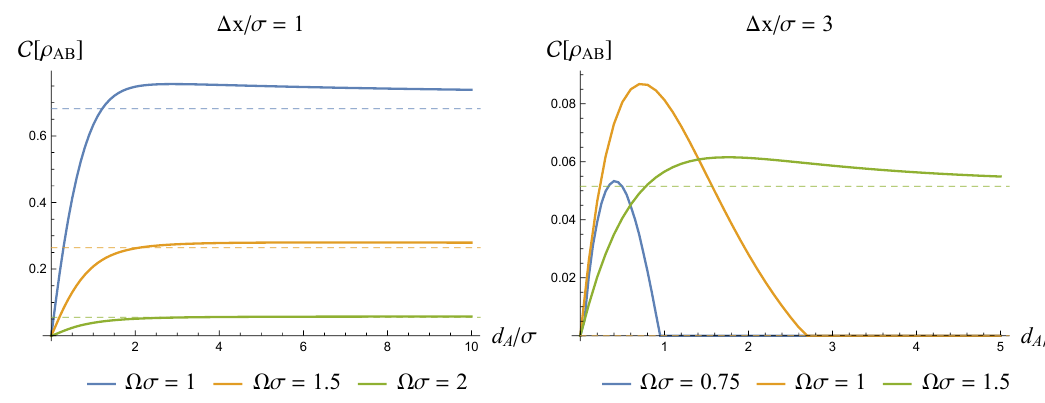
Figure 2 . Concurrence as a function of distance from mirror d A with (cid:27) = 1 and for various energy gaps. The left and right plots are obtained for di(cid:11)erent detector separations (cid:1) x=(cid:27) as indicated in the plots. The corresponding free space results are shown as dashed lines in each plot. We observe entanglement enhancement relative to that of free-space in some regions. For (cid:1) x=(cid:27) = 3 (right plot) and (cid:10) (cid:27) = 0 : 75 ; 1, the free space cases (computed by choosing (cid:3) = 10 (cid:0) 12 ) have zero concurrence (dashed lines on d A =(cid:27)